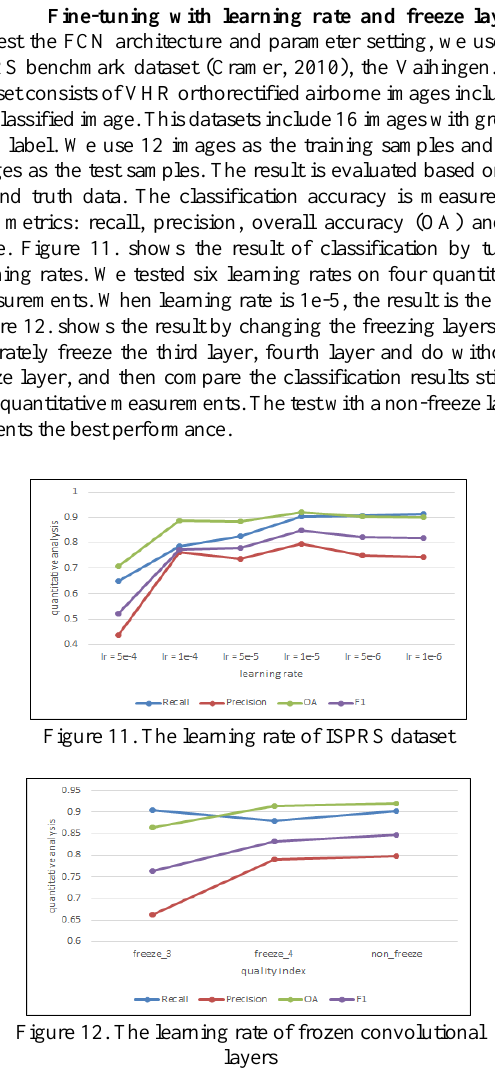
Figure 10. Removing the occluded areas to provide clean